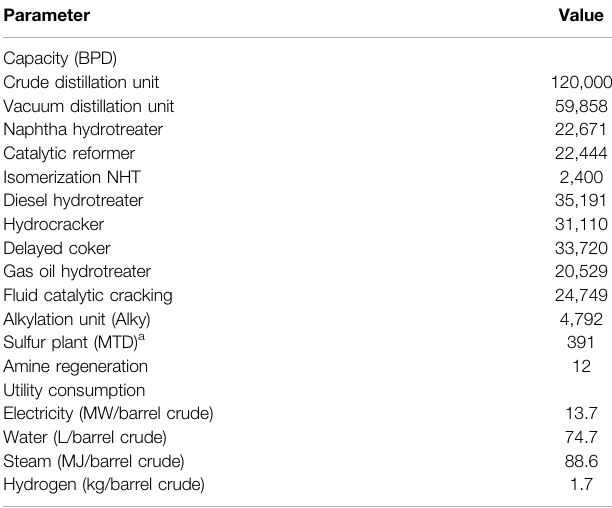
TABLE 1 | Processing capacitiesofmajor equipment inthe PRscenario and utility consumption; all values were taken from (Sun et al., 2018). Parameter